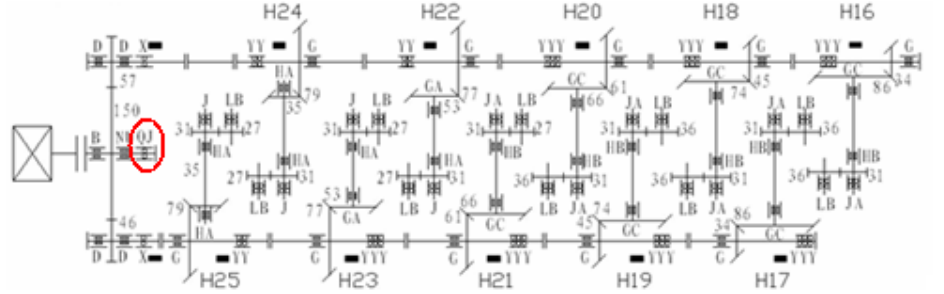
Figure 7. Driving chain of finishing mill in a steel mill.